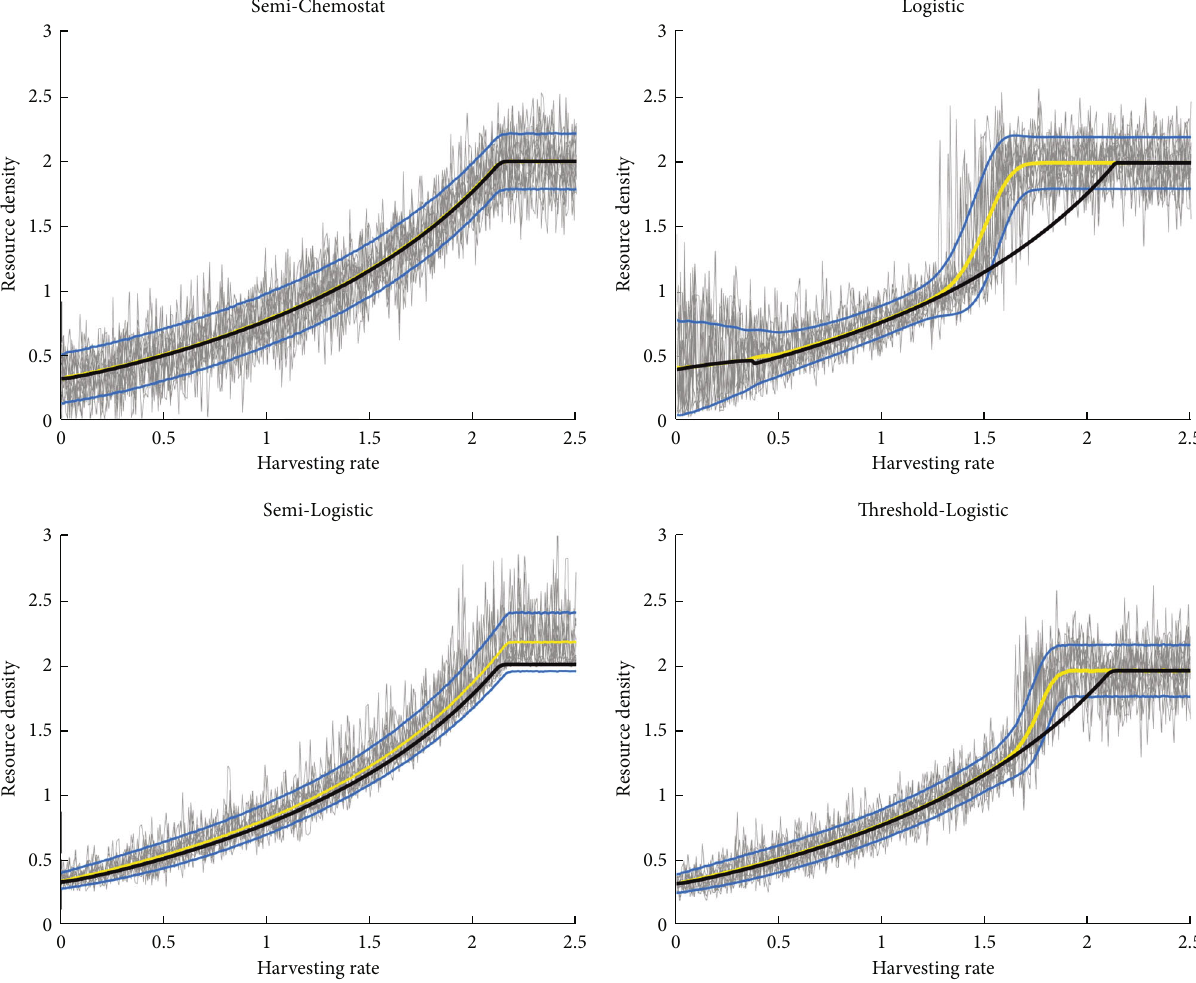
Figure 15: Resource dynamics of semichemostat, logistic, semilogistic, and threshold-logistic growth rate at steady state w.r.t. harvesting rate. The grey trajectories show the resource density from di ff erent simulations for the stochastic case. The yellow curve represents the resource mean value of the simulations. The light blue curves represent the interval of standard deviation (68%) of resource density. The black curve represents the resource for the deterministic